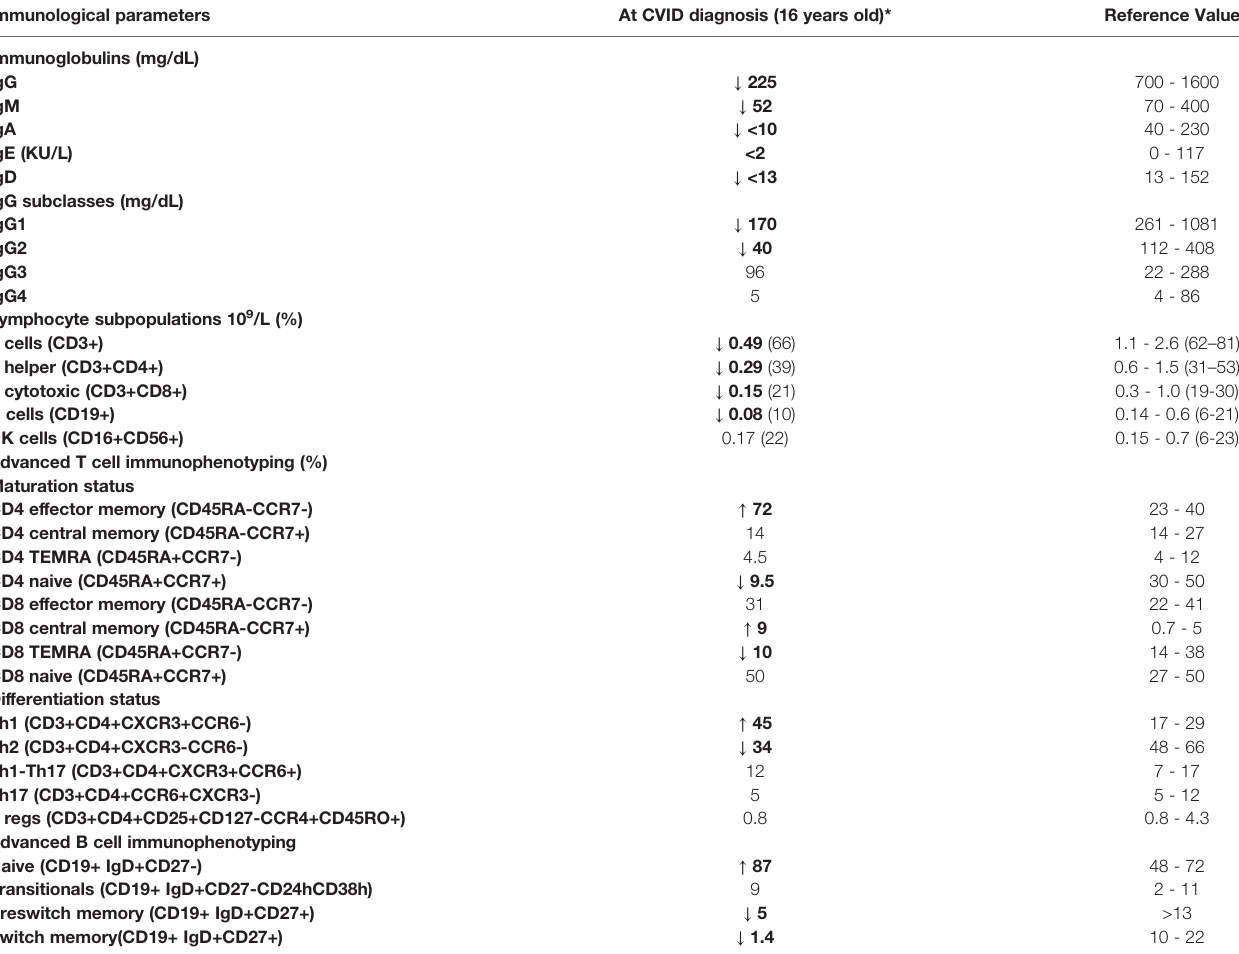
TABLE 1 | Immunological fi ndings in a patient with a 13-Mb deletion (including the NFKB1 gene) in chromosome 4q22.2-q24. Immunological